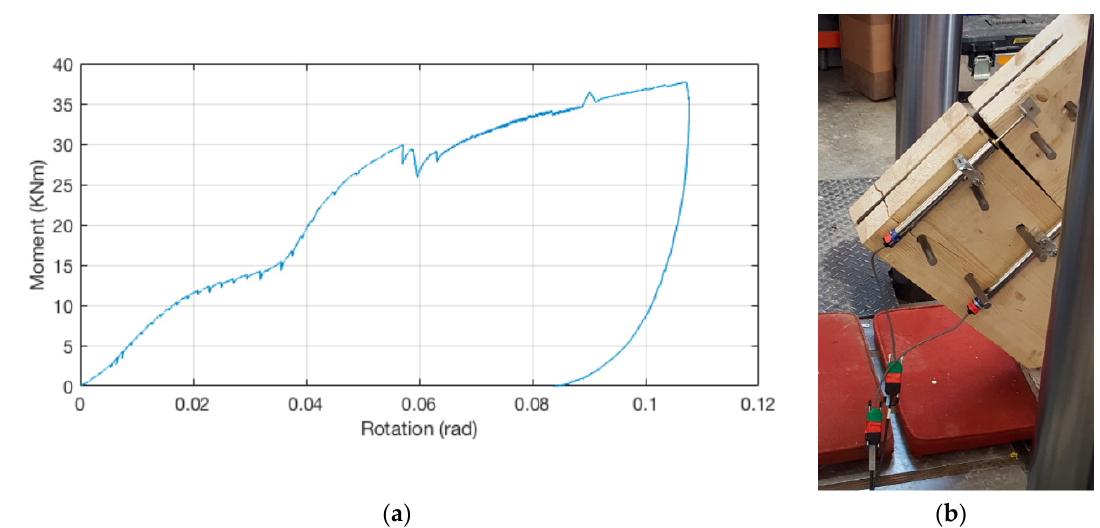
Figure 10. ( a ) Connection monotonic test results; ( b ) specimen at failure, adapted from [32].